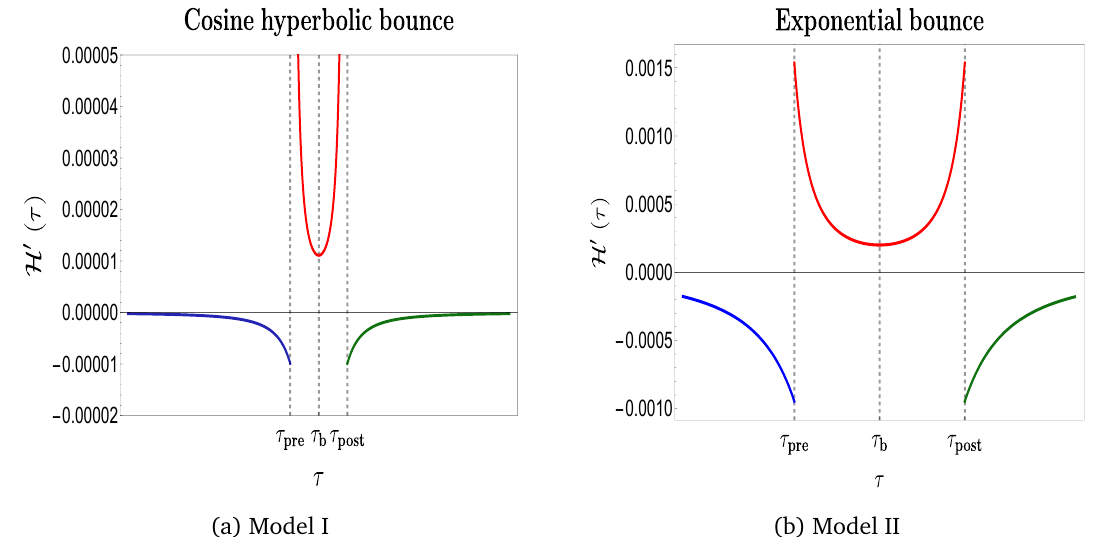
Figure 6: Variation of the derivative of the Hubble parameter wrt the conformal time showing three different regions viz. Pre-bounce, Bouncing and the Post-bounce